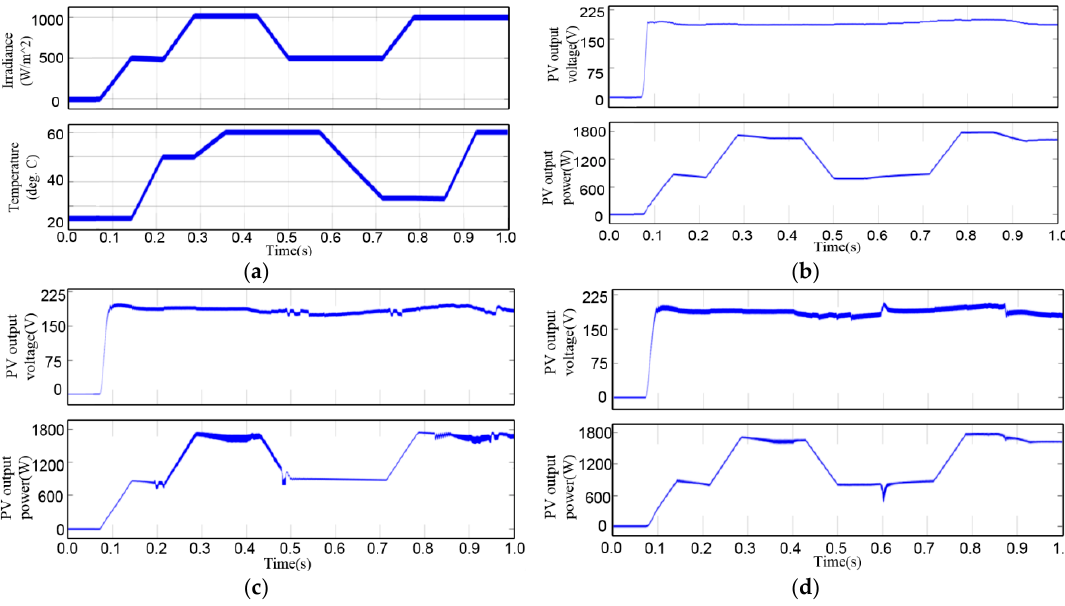
Figure 11. MPPT tracking simulation results of different control methods in variable radiation and temperature: ( a ) Changing solar radiation and temperature simultaneously; ( b ) VUFLC; ( c ) FLC; ( d ) INC.